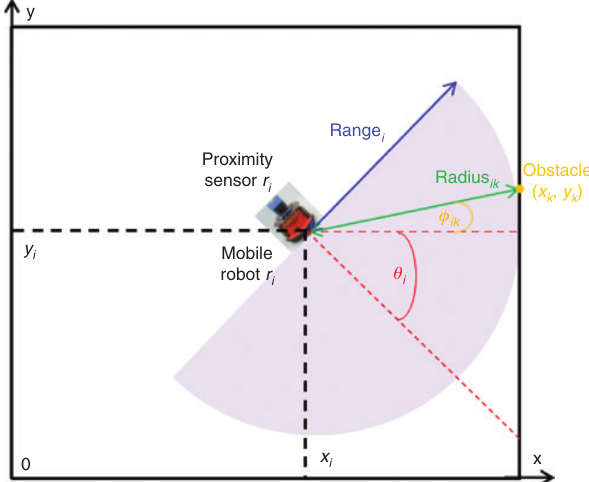
, y ) Position Coordinates using the Proximity k k